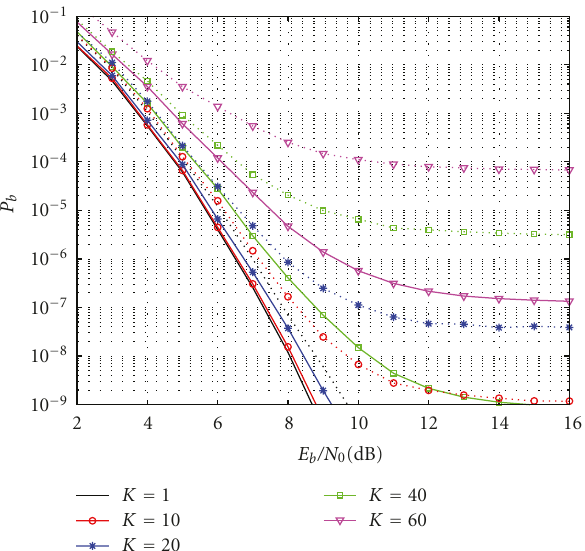
Figure 6: Performance of a convolutionally coded FHSS system over a Rician fading with κ = 10dB and perfect CSI for di ff erent number of users K and SIR = 5dB, (solid: m = 1, dashed: m = 64).